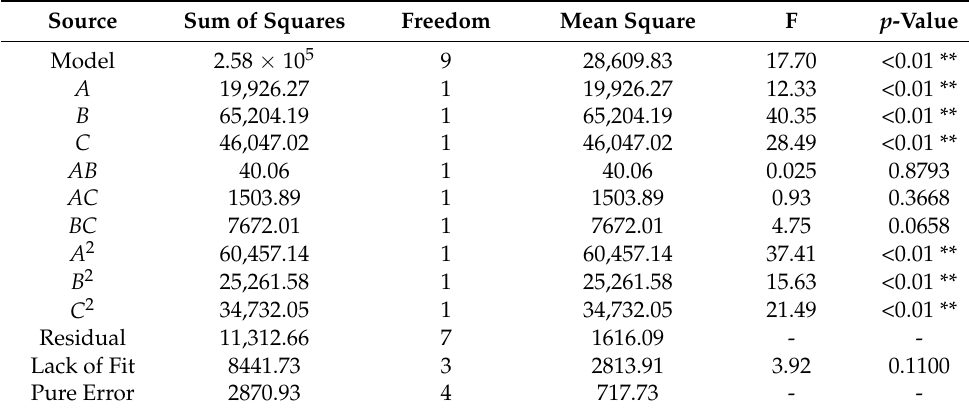
Table 7. Working resistance analysis of